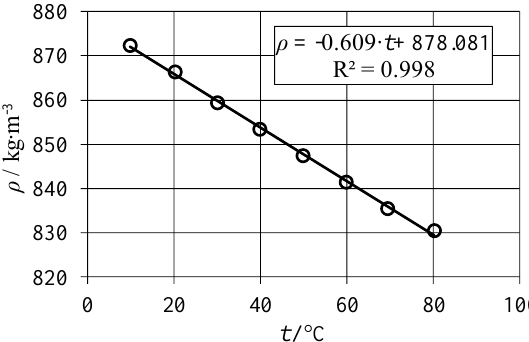
Fig. 3. Dependence of the oil density ρ on the temperature t